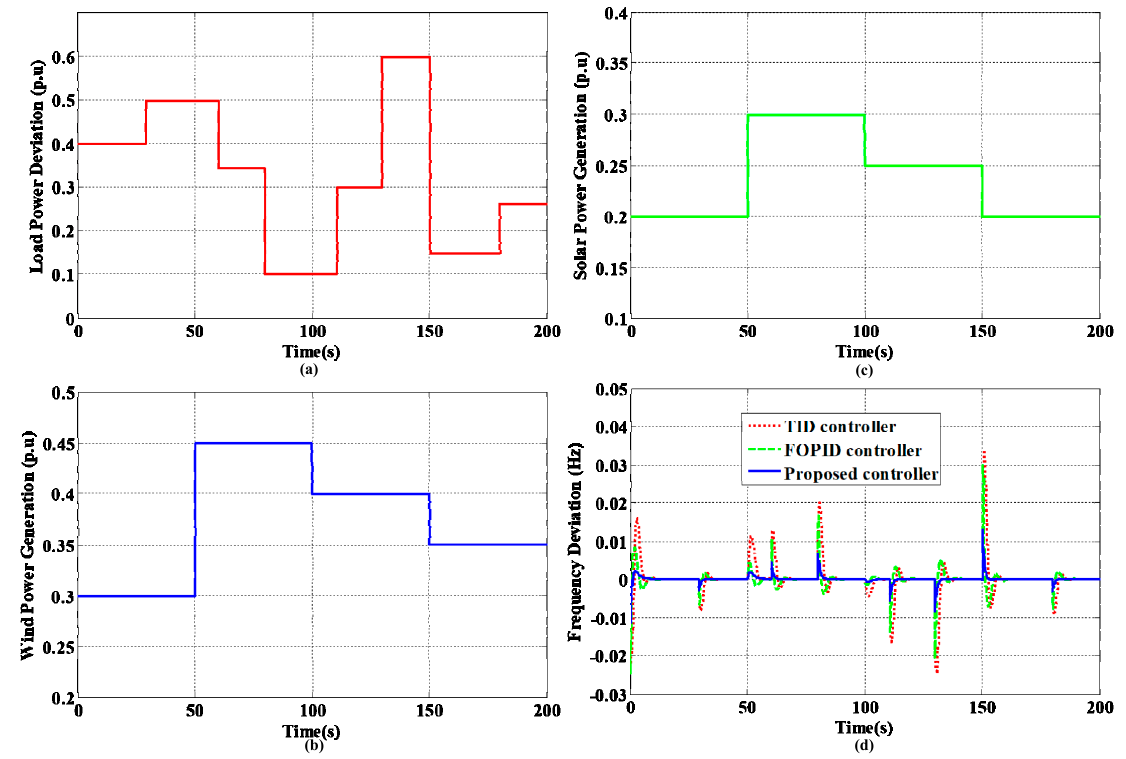
Figure 10. MG disturbances and frequency response for scenario 5.1.2. ( a ) Pattern of considered load disturbance. ( b ) WTG output power. ( c ) PV output power. ( d ) Resulted frequency responses.